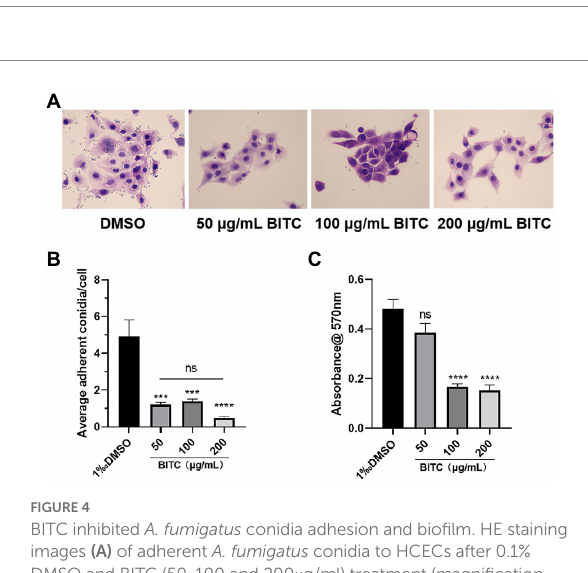
FIGURE 3 Killing mechanism of BITC on A. fumigatus. PI staining (A) for membrane integrity of A. fumigatus exposed to 0.1% DMSO and BITC (50, 100 and 200 μ g/ml), magnification ×200. SEM images of A. fumigatus hyphae morphology after treatment with 0.1% DMSO, magnification ×2,000 (B) and ×5,000 (C) and 200 μ g/ml BITC, magnification ×2,000 (D) and ×5,000 (E) . TEM images of A. fumigatus conidia, magnification ×40,000 (F) and hyphae, magnification ×15,000 (G) after treatment with 0.1% DMSO and 200 μ g/ml BITC. Effects of BITC (50, 100, and 200 μ g/ml) on the increase of ROS (H) in A. fumigatus conidia. Values represent as means ± SD (**** p < 0.0001).